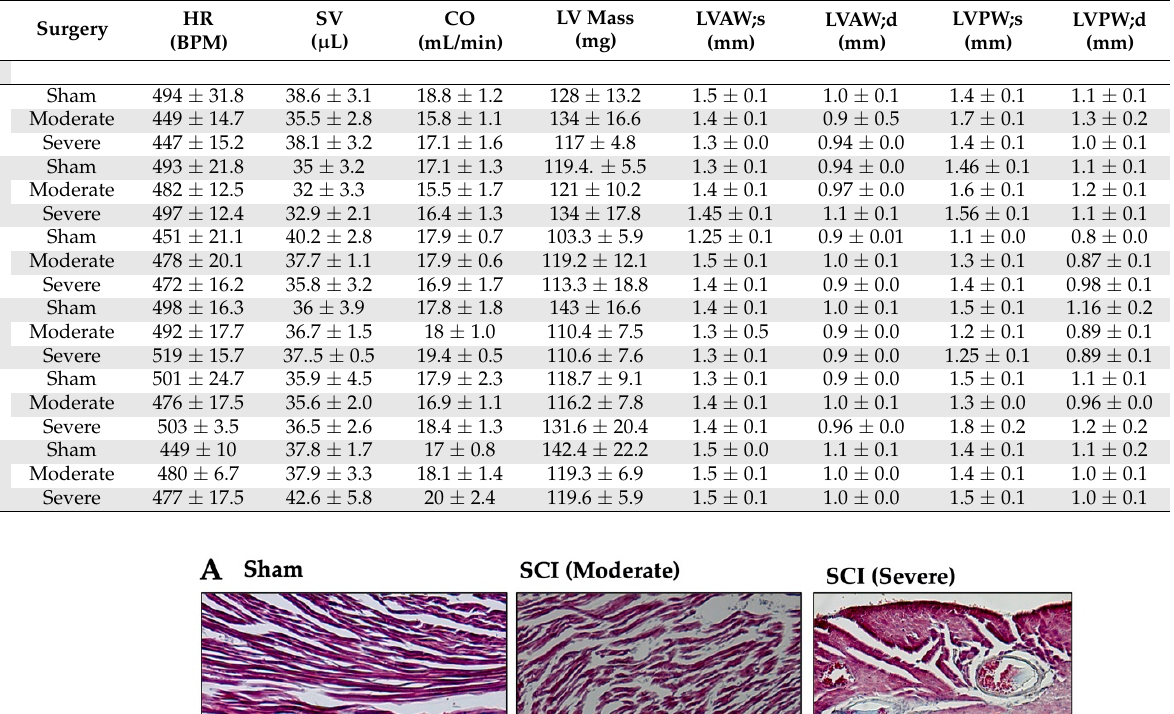
Table 2. Parameters of echocardiography results of sham, moderate, and severe SCI at different time points . Data are means ± S.E.M; n = 5–9 per group. Parameters of cardiac structure and function in mice before SCI and at 4-, 8-, 12-, 16-, and 20-weeks post-SCI of sham, moderate (50-kdyn), and severe (75-kdyn) mice. HR, heart rate; SV, stroke volume; CO, cardiac output; LV Mass, left ventricular mass; LVAW;s, LV anterior wall thickness at the end of systole; LVAW;d, LV anterior wall thickness at the end of diastole; LVPW;s, LV posterior wall thickness at the end of systole; LVPW;d, LV posterior wall thickness at the end of diastole; LVID;d, LV anterior diameter at the end of diastole.